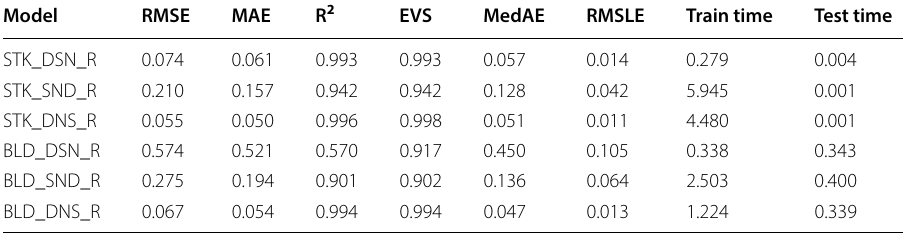
Table 23 Stacking and blending ensemble regressors error metrics result on GSE dataset Model